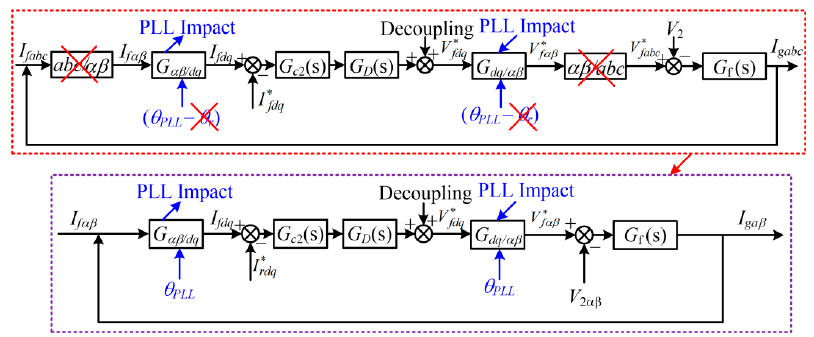
Figure 7. Simplified control diagram of GSC and LCL filter.